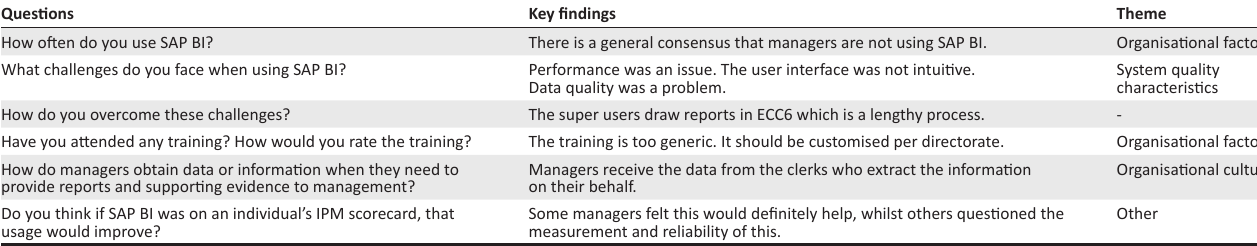
TABLE 5: Mapping of themes to interview